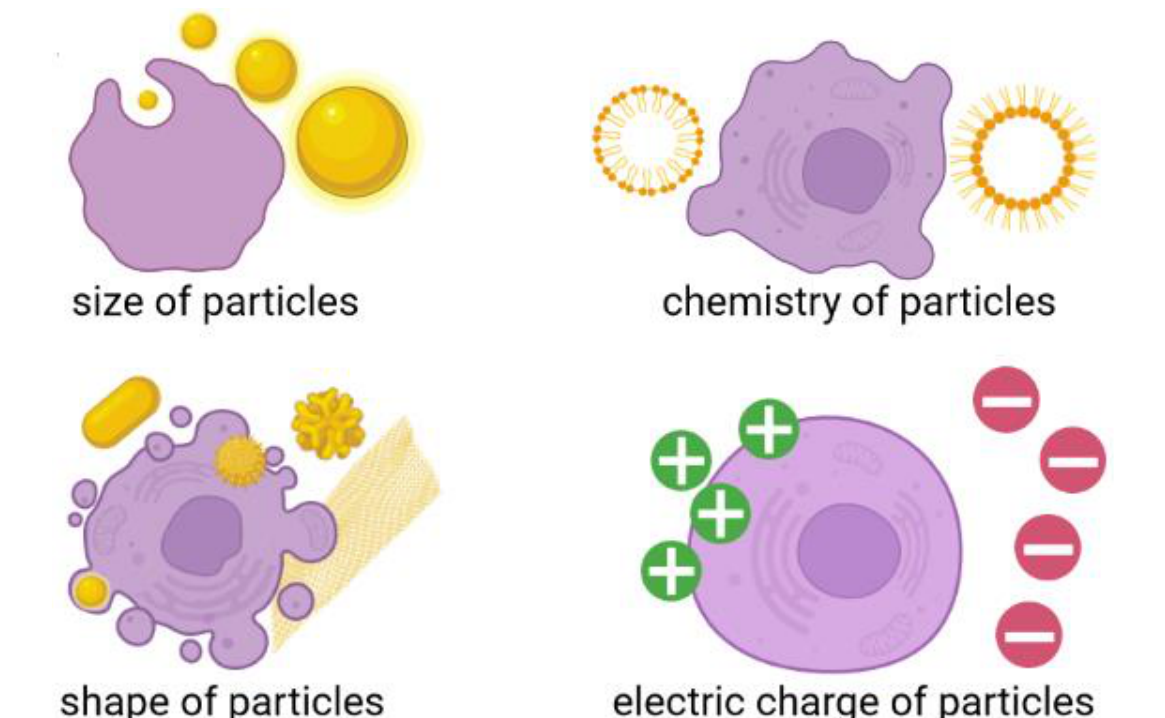
Figure 3. Different factors affecting cell-nanomaterial interaction. Composed with BioRender [21].